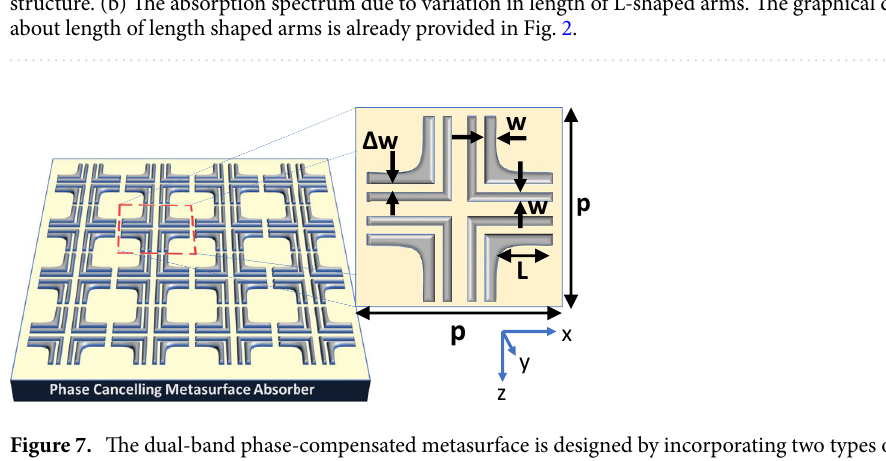
Figure 7. The dual-band phase-compensated metasurface is designed by incorporating two types of resonator structures in the supercell so that there are a total number of eight L-shaped structures. The length of the smaller arms (L) is 512 nm, w = 112 nm and (cid:31) w = 75 nm. The dimensions of the larger L elements are similar to